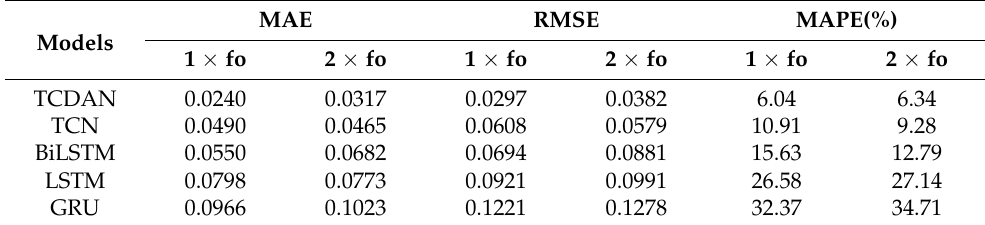
Table 2. Evaluation metrics of different prediction models for Bearing 3_1.